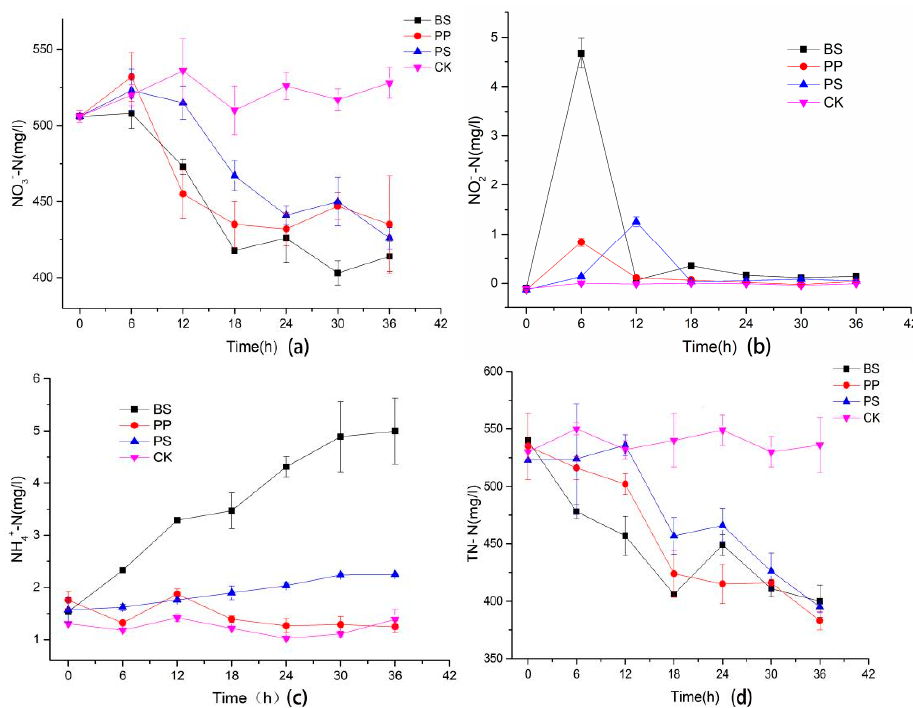
Figure 2. The concentration changes of NO 3- -N, NO 2- -N, NH 4+ -N, TN-N, ( a ) represents the NO 3- -N, ( b ) represents the NO 2- -N, ( c ) represents the NH 4+ -N, ( d ) represents the